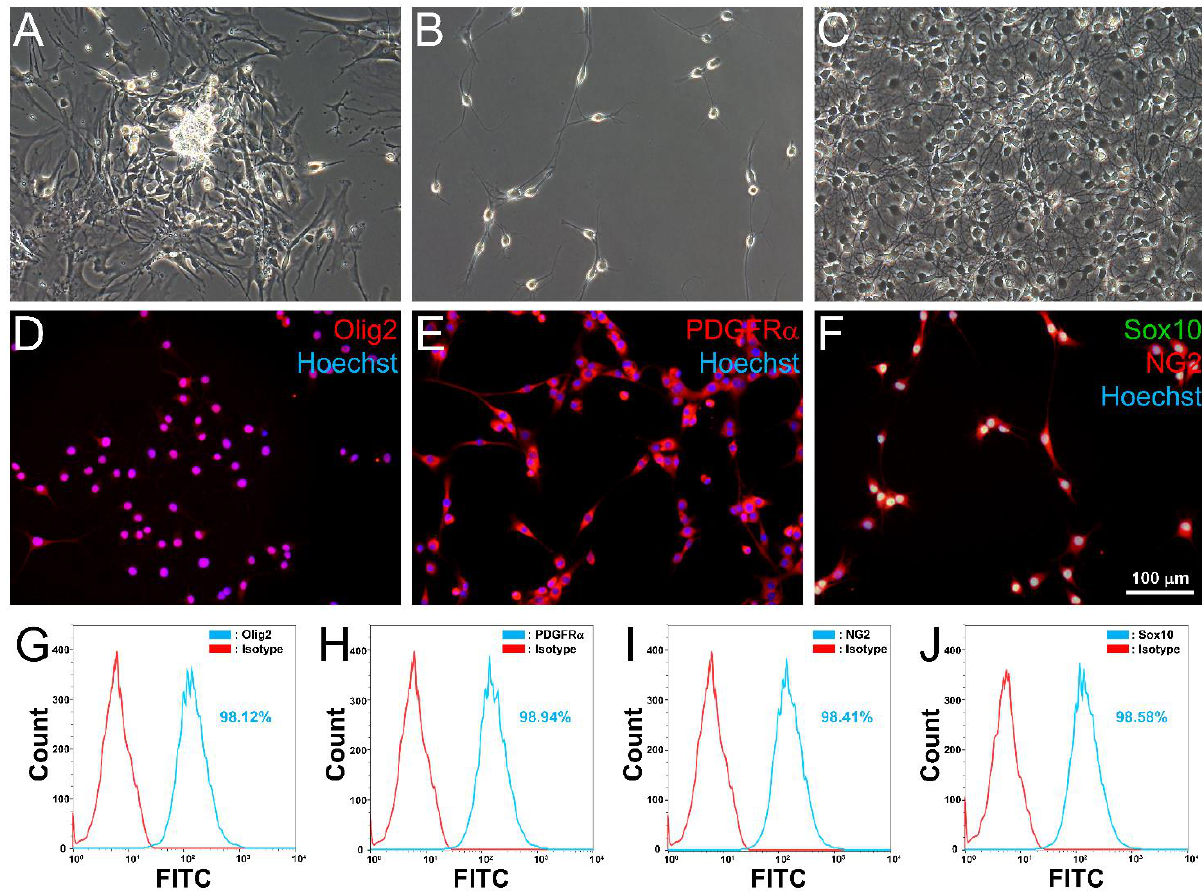
Figure 3. Derivation of OP-like cells. Spindle-shaped cells exited from adherent spheres 7 days after glia induction in adherent culture ( A ). Following re-plating, cells developed bi/tri-polar OP-like morphology ( B ). At higher cell density, OP-like cells became polydendritic ( C ). These cells were positive for the OP markers Olig2 ( D ), PDGFR α ( E ), NG2, and Sox10 ( F ). Flow cytometric analysis of OP-like cells found then immunopositive for Olig2, PDGFR α , NG2, and Sox10 in 98.12% ( G ), 98.94% ( H ), 98.41% ( I ), and 98.56% ( J ) of cells respectively. Histograms of a representative experiment are shown. n = 4 independent preparations.